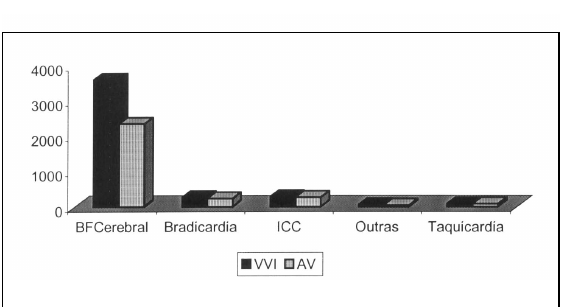
Fig. 7 - Modos de estimulação utilizados nos implantes iniciais, agru- pados segundo a indicação clínica para o implante de marcapasso.